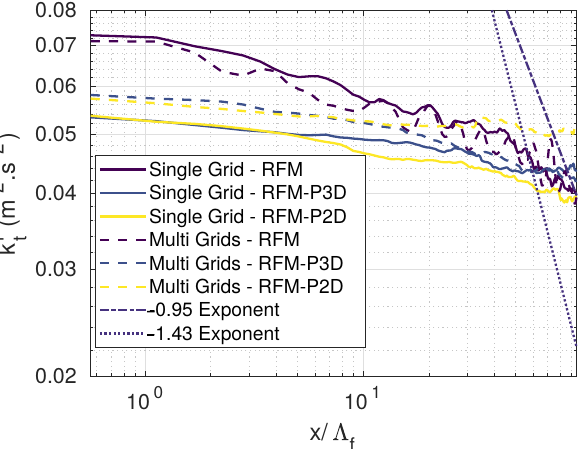
Figure 8. Resolved turbulent kinetic energy k r decay along x for the Single Grid and Multi Grids sim- t ulations. Decay exponents from grid-generated turbulence experiments of Mohamed and Larue